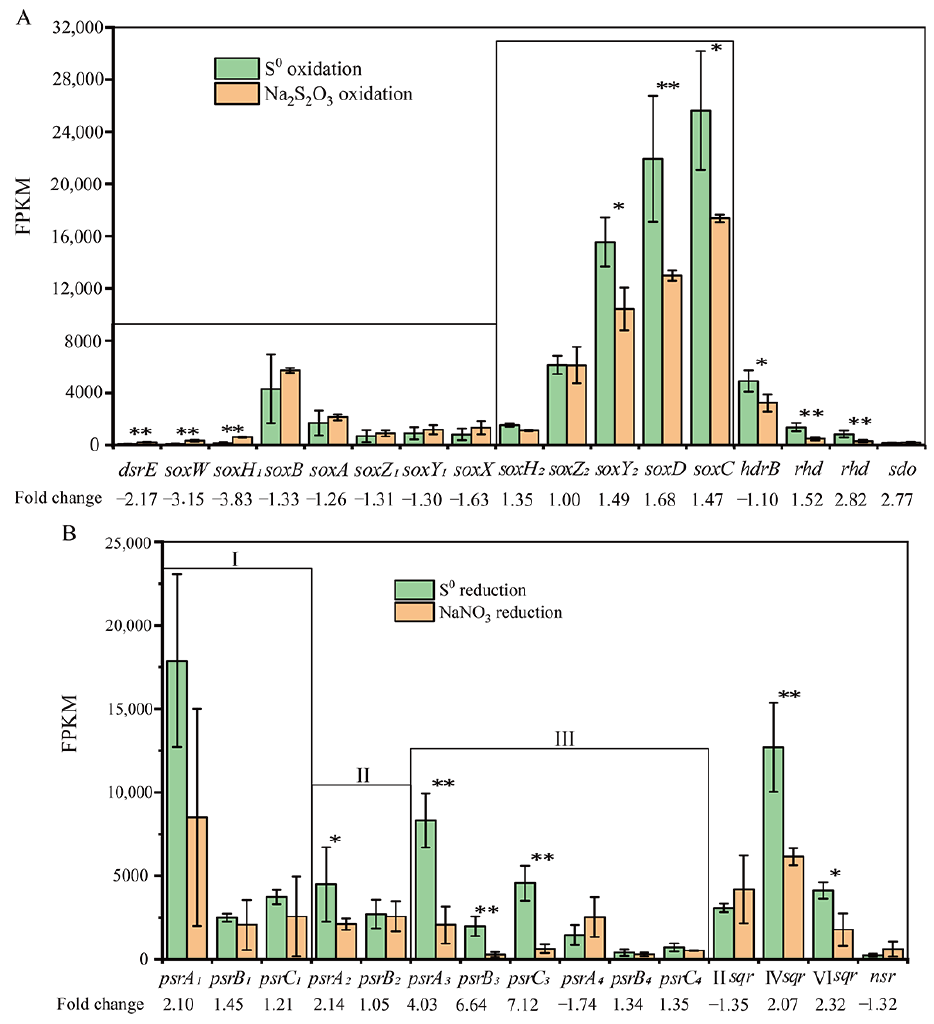
Figure 6. The relative abundance and expression of genes related to S 0 oxidation ( A ) and S 0 reduction ( B ) in strain ST-419. Light green bars show the average values of strain ST-419 grown on S 0 oxidation and reduction, and light orange bars show the average of cultures grown on thiosulfate oxidation and nitrate reduction. Statistically significant differences are denoted by one asterisk ( p adj < 0.05) or two asterisks ( p adj < 0.01). The symbols of “I”, “ Ⅱ ” and “ Ⅲ ” represente the different gene cluster of polysulfide reductases. Normalized gene expression is plotted as fragments per kilobase and million reads (FPKM). Error bars indicate the standard deviation from triplicate cultures.